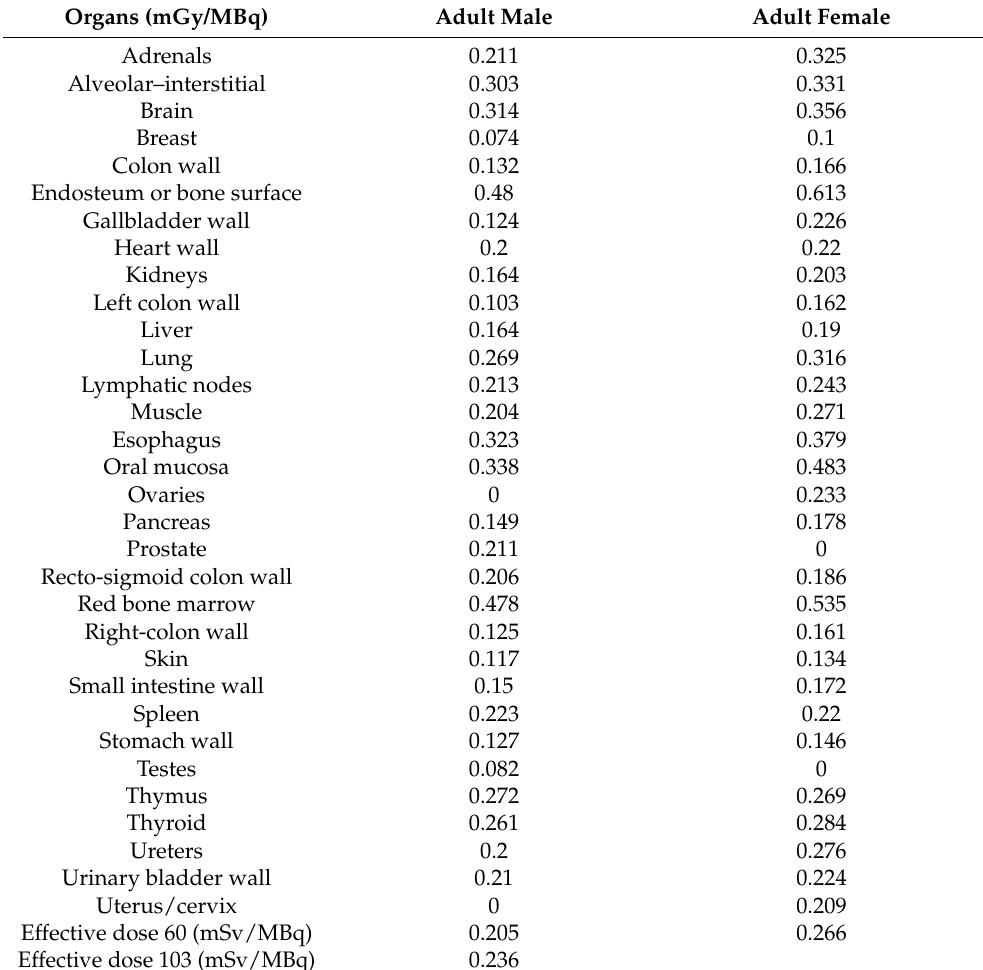
Table 5. Estimation of absorbed dose of 89 Zr-oxalate in various organs using IDAC 2.1 and WinAct, measured in